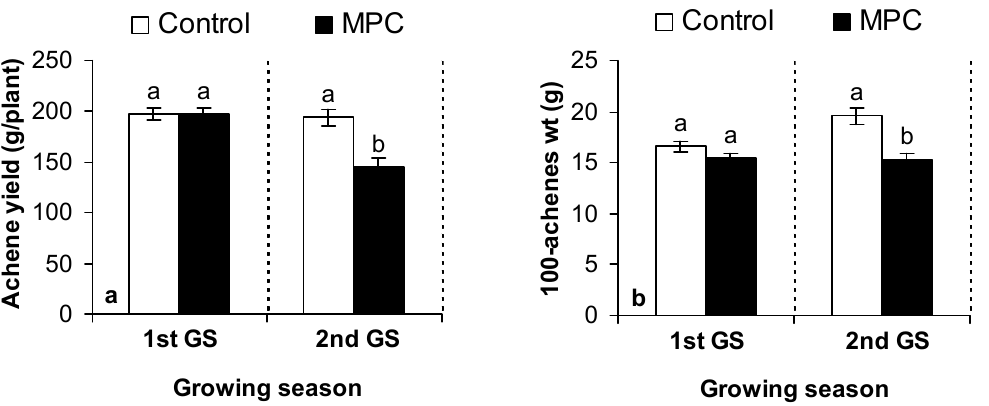
Figure 4. Achene yield ( a ) and 100-achenes weight ( b ) of sunflower plants as influenced by foliar treatments of MPC (37.5 + 37.5 g ha − 1 in the 1st growing season (GS) and 37.5 + 37.5 + 37.5 g ha − 1 in the 2nd GS). Different letters within each GS show statistically significant differences at p < 0.05 and vertical bars denote standard errors of means ( n = 12). MPC, mepiquat chloride.